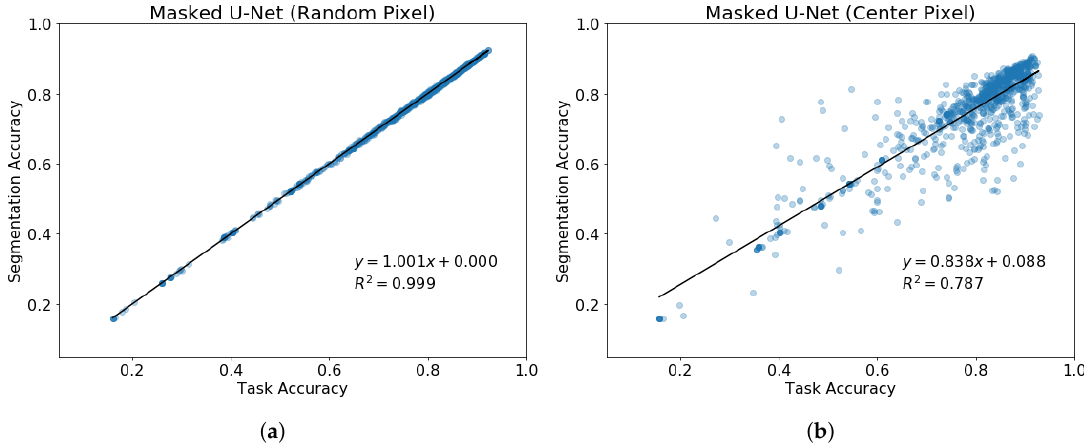
Figure A2. Scatter plots and corresponding least squares fit between validation set task accuracy and segmentation accuracy for ( a ) randomly located pixel labels and ( b ) pixel labels always at the center of the tile for the masked U-Net model. Points are shown for training set sizes of n ∈ { 100,1000,10,000 } across 10 runs of [ 50,20,20 ] epochs,